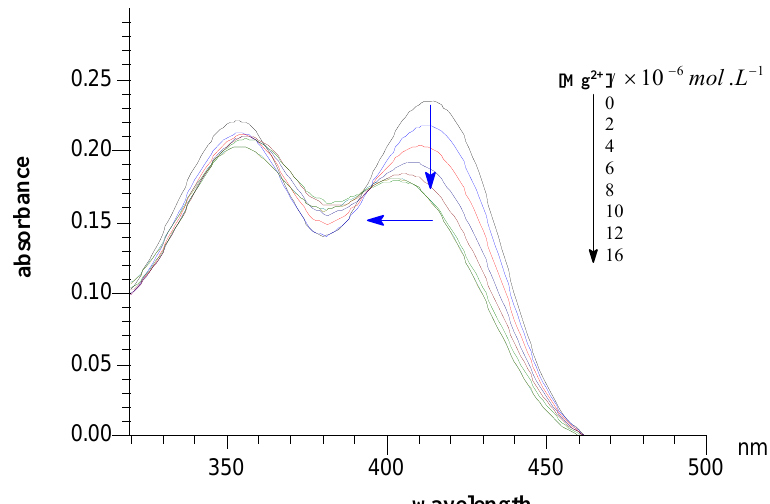
Figure 2 . Changes of UV-vis spectra with 14a in CH of [Mg 2+ ] at 25 °